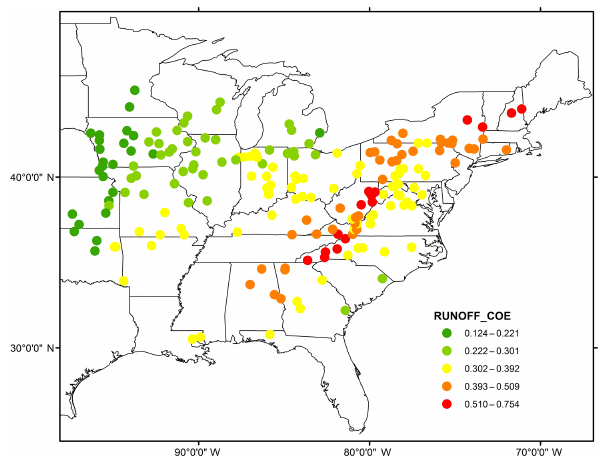
Figure 14. The discharge coefficient of the catchments selected for the